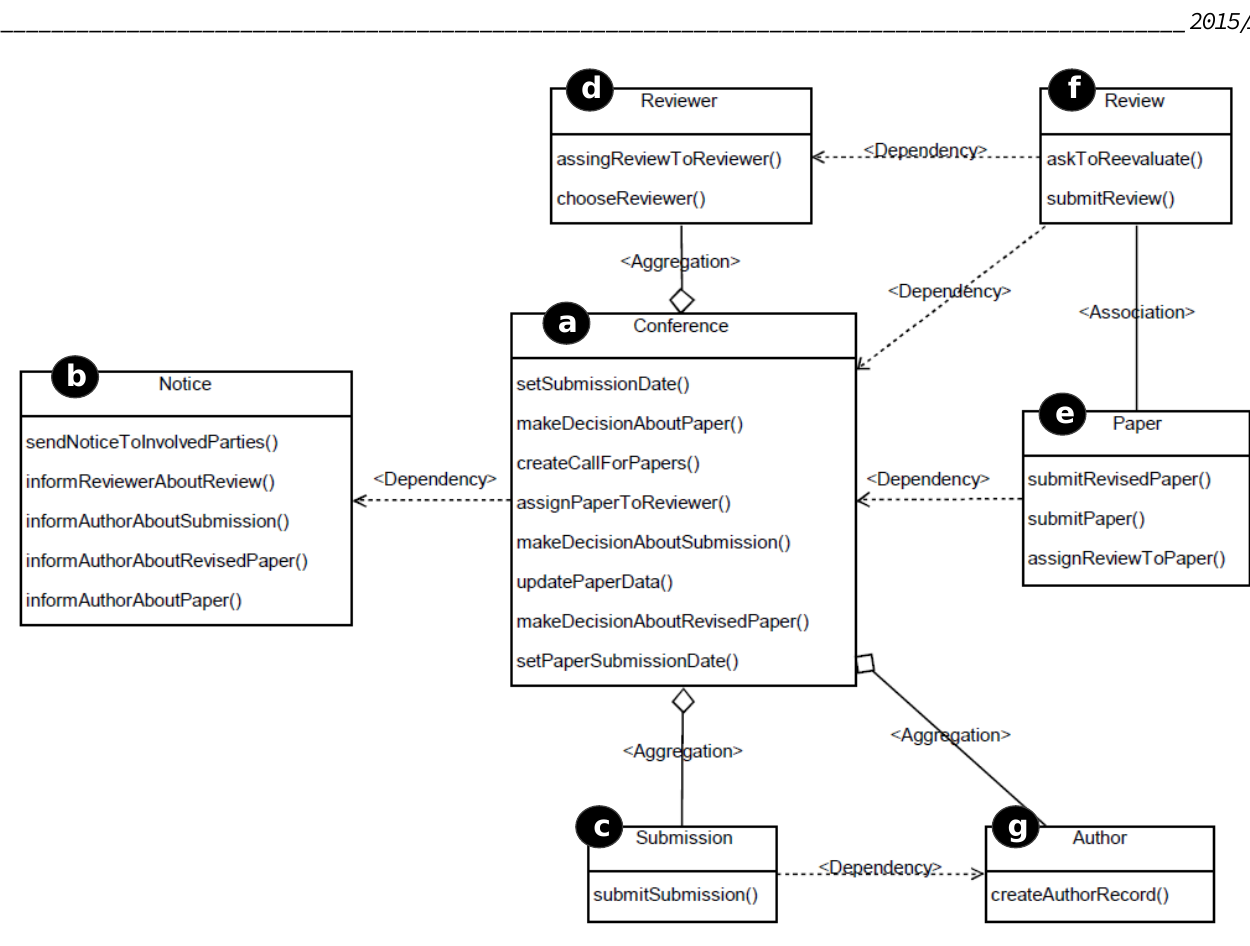
Fig. 2. The UML class diagram generated from the two-hemisphere